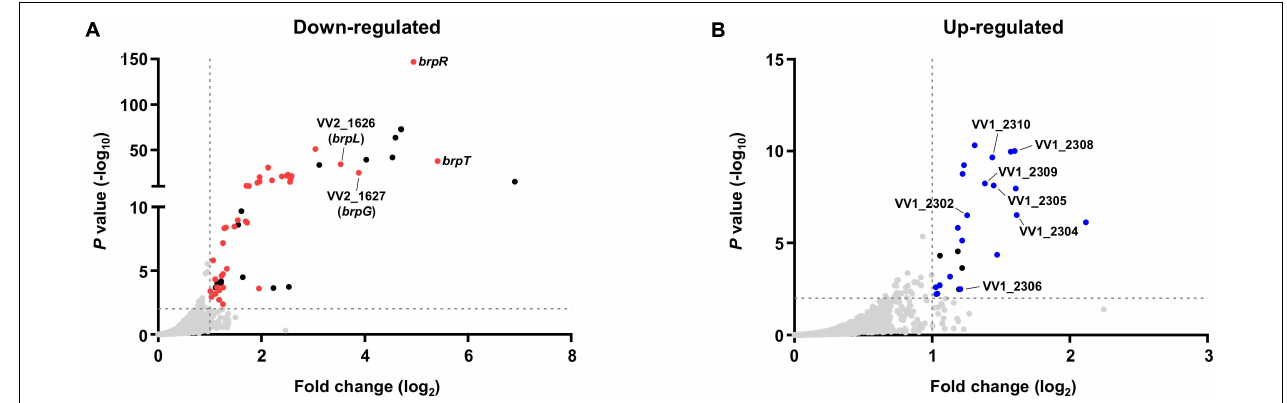
FIGURE 3 | Transcriptome analyses for the genes differentially expressed by BrpR. Transcriptome analyses plotted the genes down-regulated (A) or up-regulated (B) by the brpR deletion as dots. The red dots (A) or blue dots (B) represent the differentially expressed genes with annotated gene products, and the black dots indicate the genes encoding hypothetical proteins. The gray dashed lines indicate the cutoffs for differential expression of fold change > 2 and P value < 0.01.